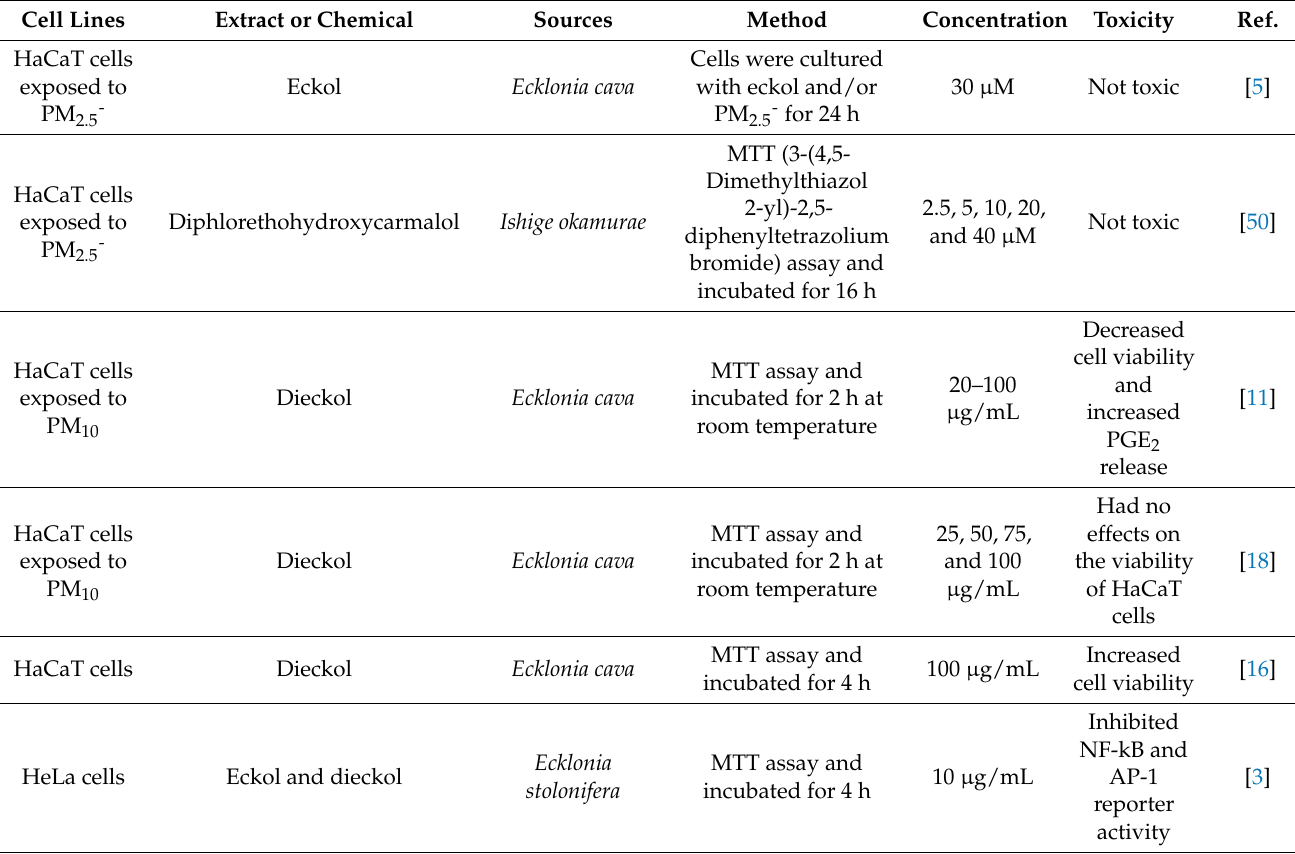
Table 2. Studies of safety and toxicity of phlorotannins extracted from brown seaweeds, as measured in human and animal cell